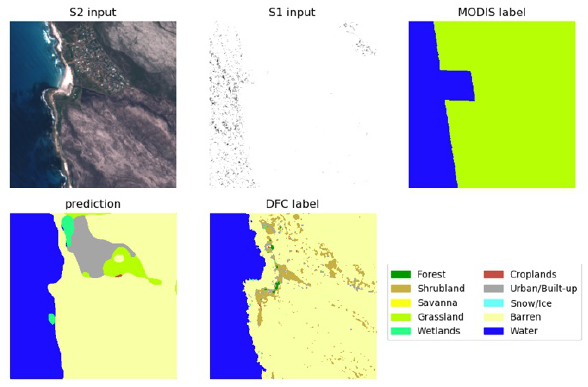
Figure 7: Reduced impact of the weak MODIS label